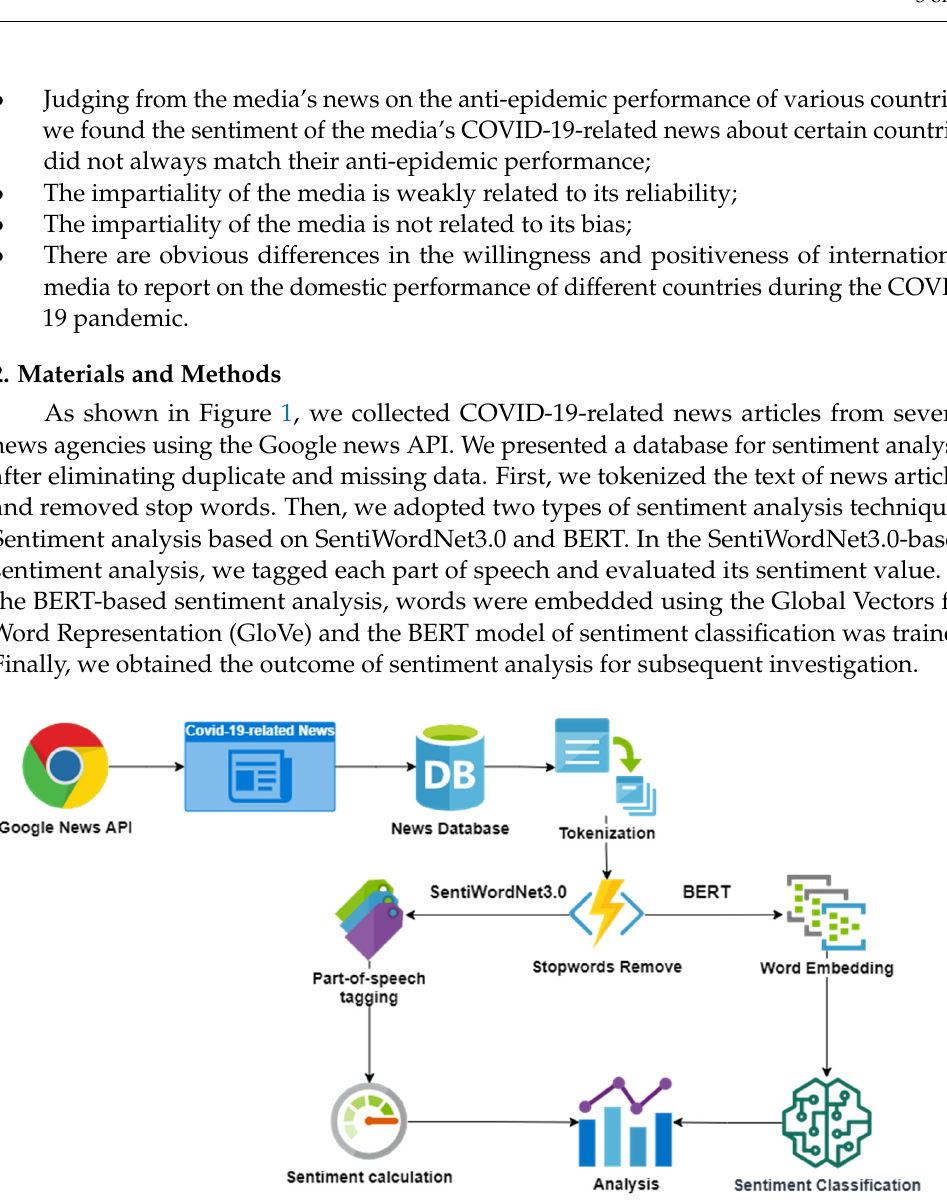
Figure 1. The Flowchart of Data Collection and Sentiment Analysis.